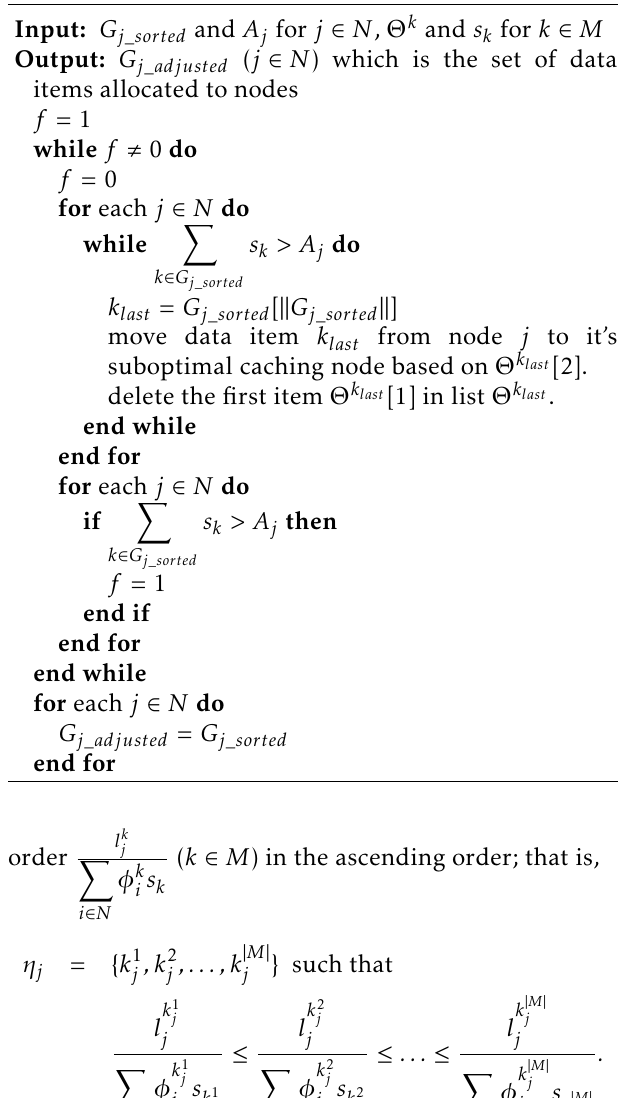
Algorithm 1 Data item reallocation algorithm. Algorithm 2 Additional data item allocation algorithm.